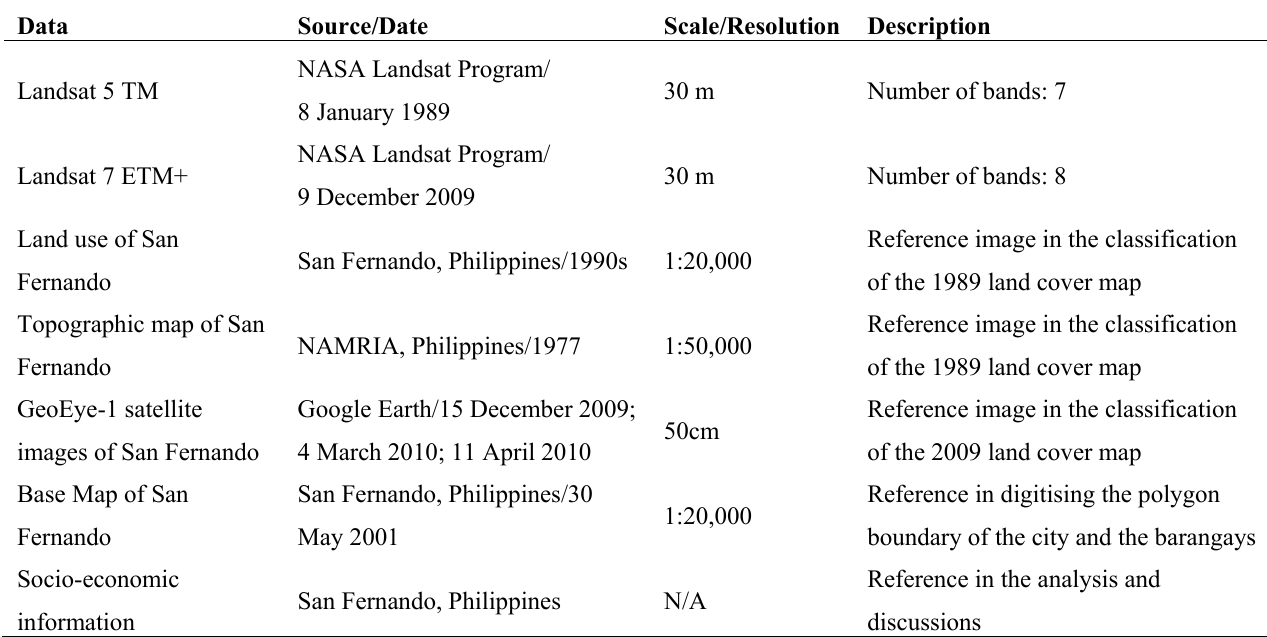
Table 1. Data used and their